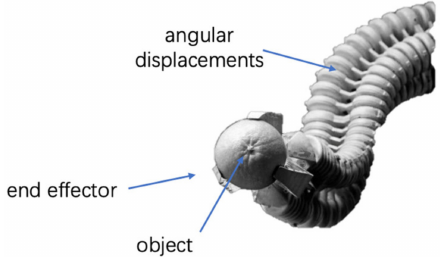
Figure 5. Bionic Handling Assistant (2010)